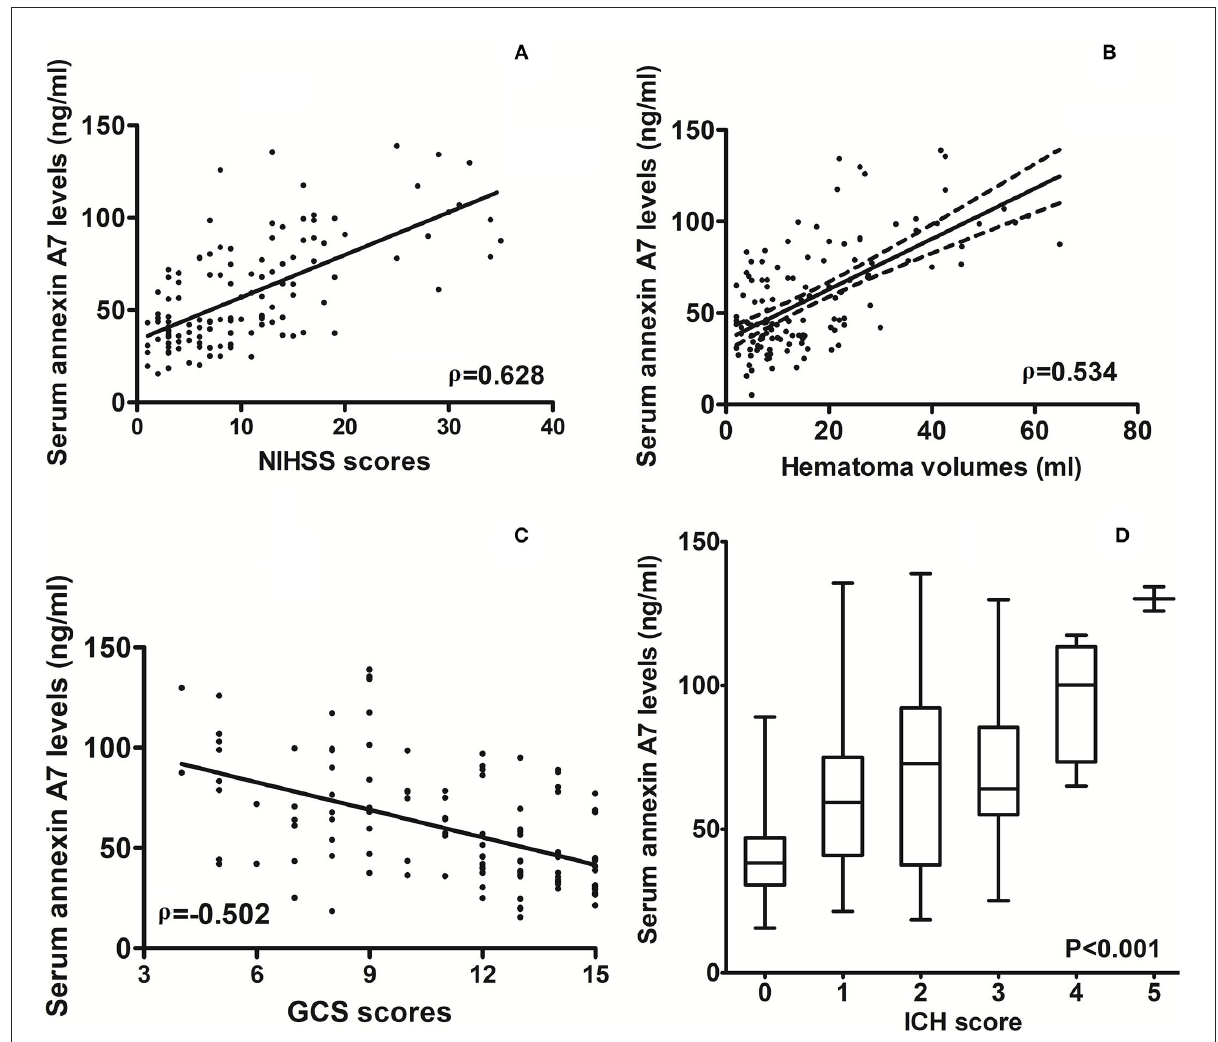
FIGURE3 Relationship between serum annexin A7 levels and illness severity after spontaneous intracerebral hemorrhage. (A) Correlation of serum annexin A7 levels with National Institutes of Health Stroke Scale scores following acute intracerebral hemorrhage. (B) Relationship between serum annexin A7 levels and hematoma volume after acute intracerebral hemorrhage. (C) Relation of serum annexin A7 levels to Glasgow Coma Scale scores after acute intracerebral hemorrhage. (D) Differences in serum annexin A7 levels across intracerebral hemorrhage scores. Bivariate correlations were analyzed using the Spearman’s correlation coefficient, and associations were reported as r values. Comparison of data was done among multiple groups using the Kruskal–Wallis H test. Graphs show that serum annexin A7 levels were significantly associated with stroke severity (all P < 0.001). NIHSS, National Institutes of Health Stroke Scale; GCS, Glasgow Coma Scale; ICH, intracerebral